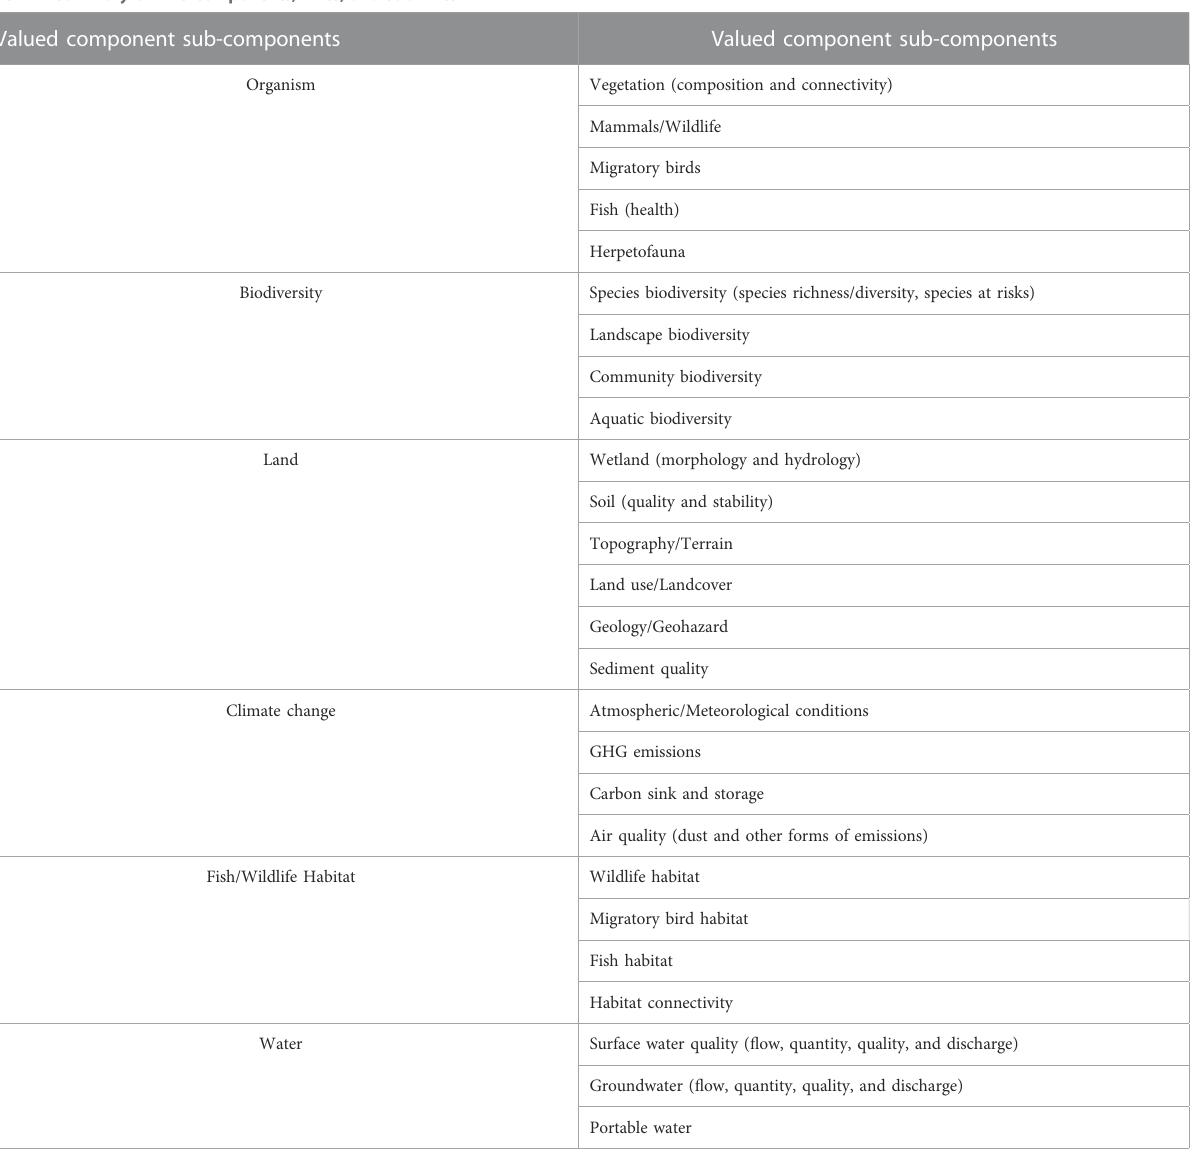
TABLE 1 Summary of VEC Components, VECs, and sub-VECs. Valued component